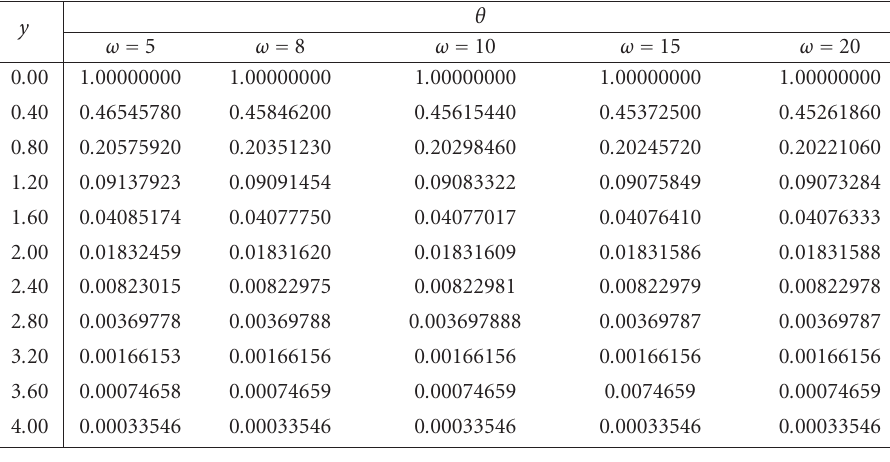
Table 4.2. Temperature distribution for Gr = 5 . 0, S = 1 . 0, Pr = 2 . 0.